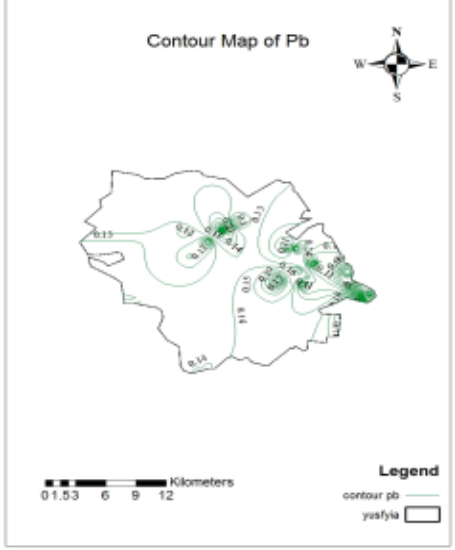
Fig.18: The interpolation and contour line of Cd map in ppm.